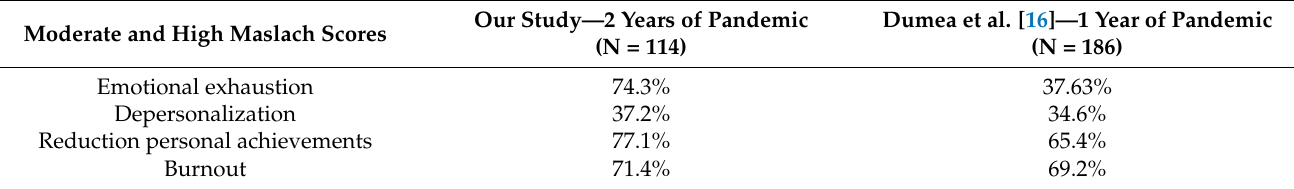
Table 11. Comparisons of the Maslach syndrome scale and subscales between our study and the study of Dumea et